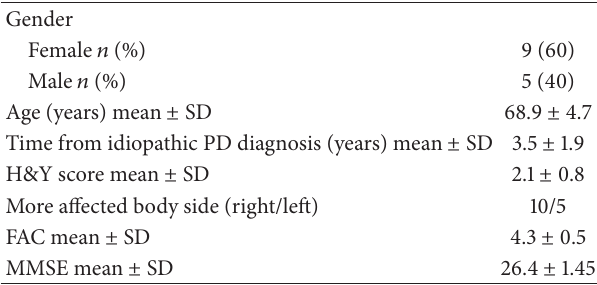
Table 2: Demographical and clinical characteristics of 15